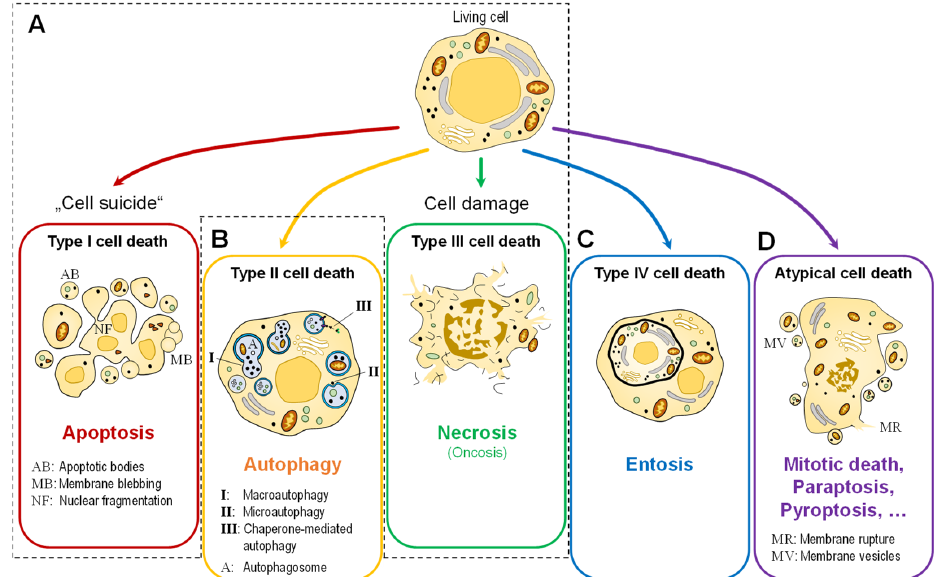
Figure 1. Simplified representation of the morphologically distinguishable types of cell death. ( A ) The two classical main types, apoptosis (type I) and necrosis (type III). Recent research also distinguishes between two further types: ( B ) autophagic cell death (type II) and ( C ) entosis (type IV). ( D ) Other (molecular) types are grouped under the term “atypical cell death”.